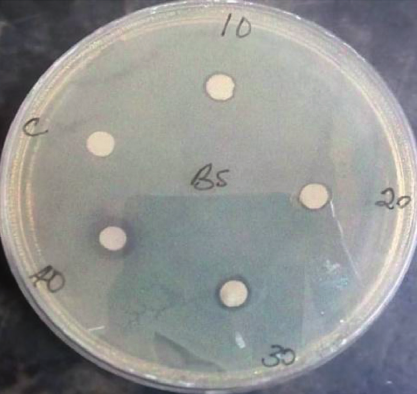
2 (H 2 O) 2 ] against E. coli.